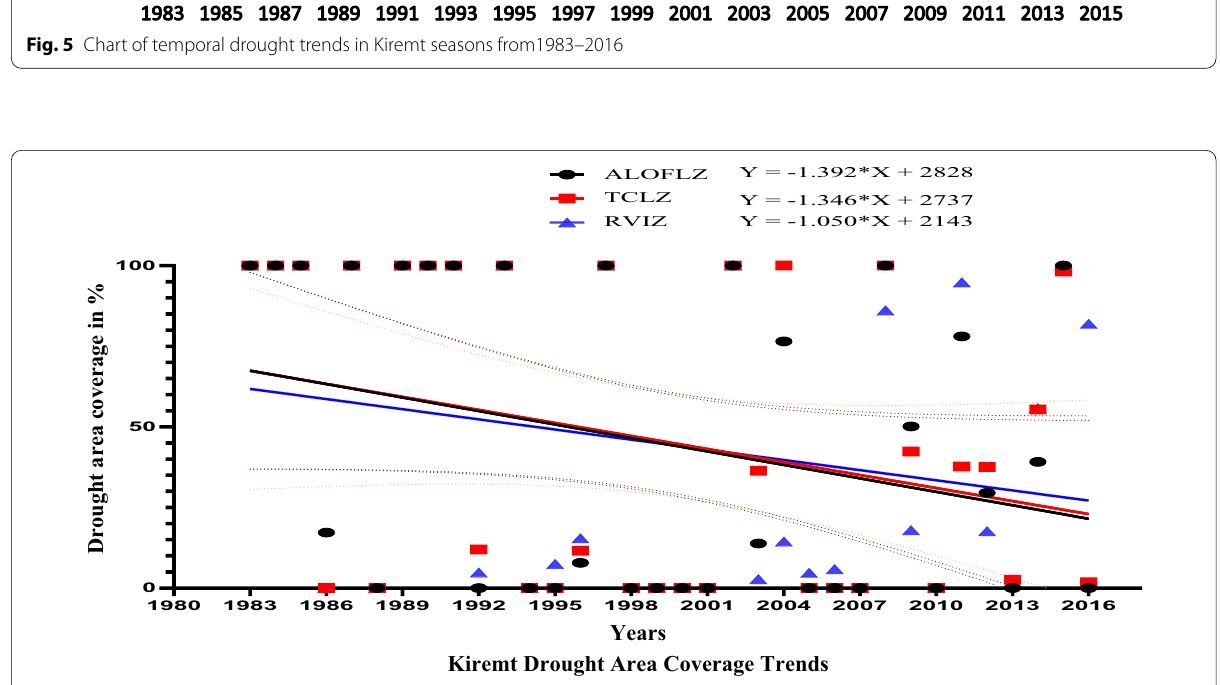
Fig. 6 The spatial drought trends in % of area coverage from 1983 to 2016 using GraphPad Prism in Kiremt